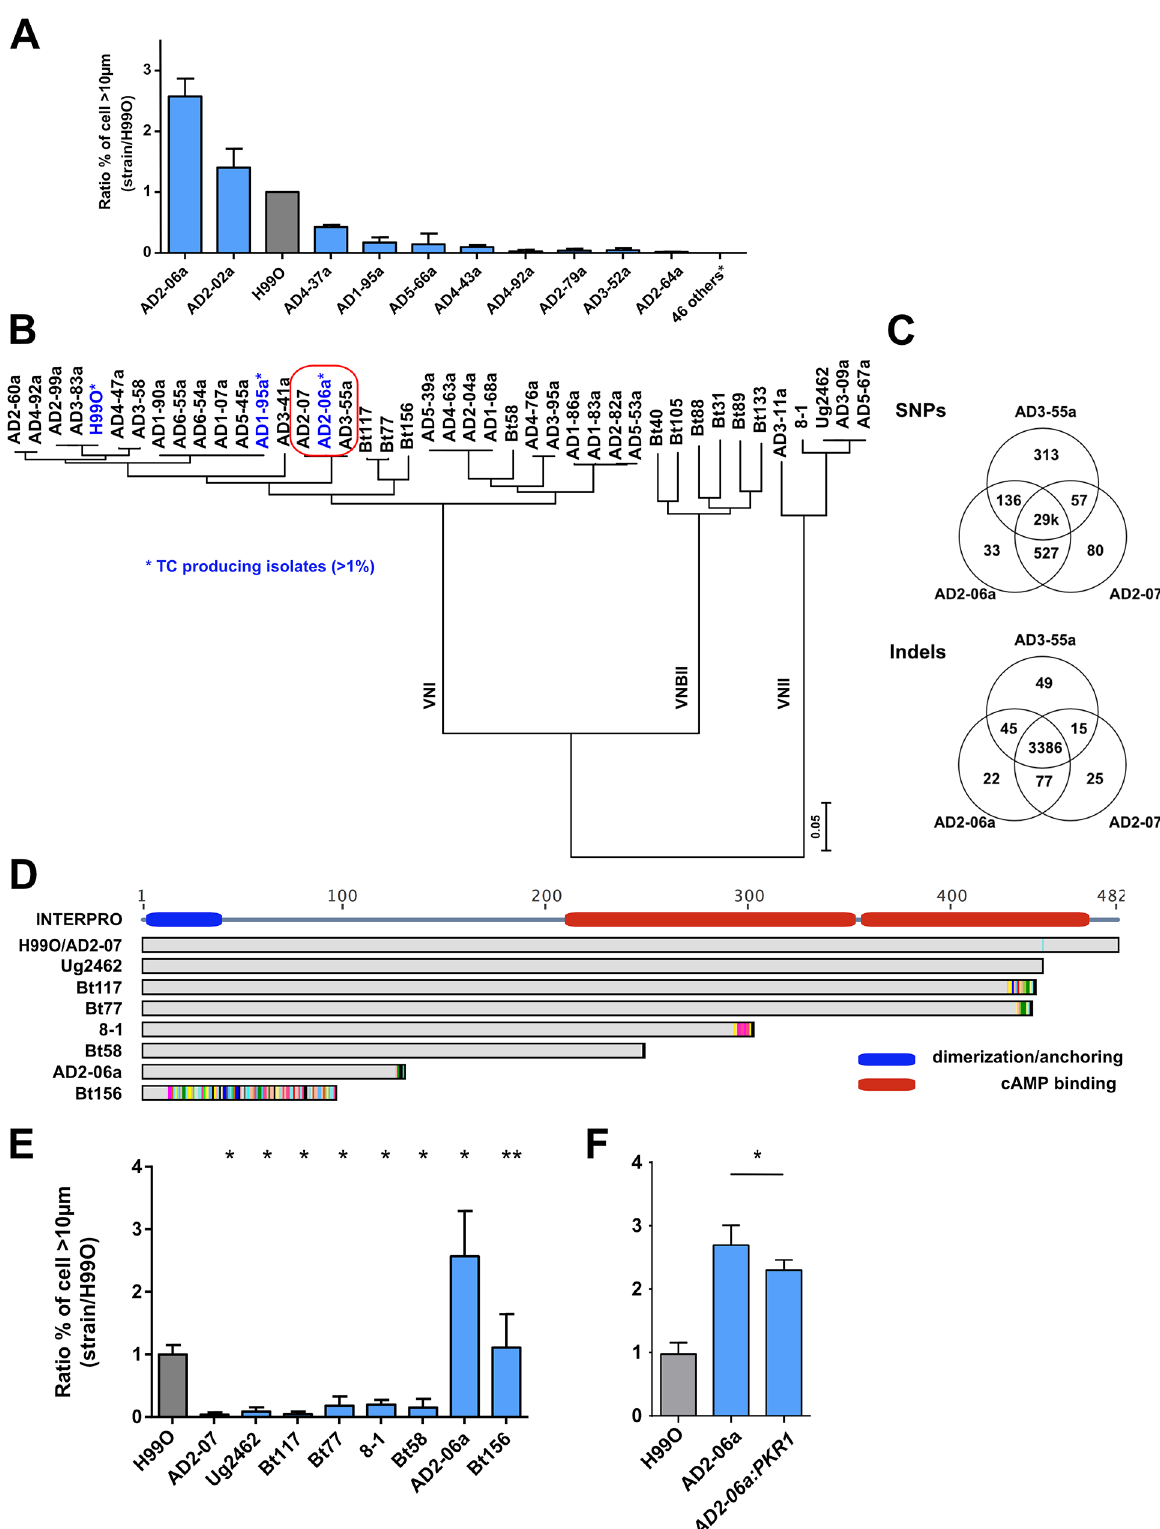
Fig 8. Non-synonymous mutation of PKR1 enhances titan cells generation based on clinical isolates analysis. ( A ) The screening of 56 C . neoformans serotype A MAT α french clinical isolates identified isolates AD2-06a (ratio = 2.6±0.2) and AD2-02a (ratio = 1.4±0.2)as titan cells